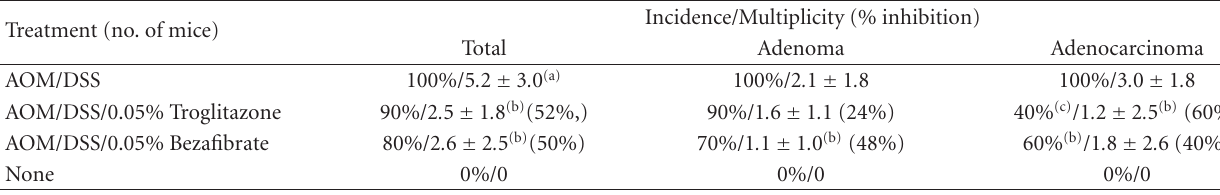
Table 2: E ff ects of PPAR ligands on colon carcinogenesis in